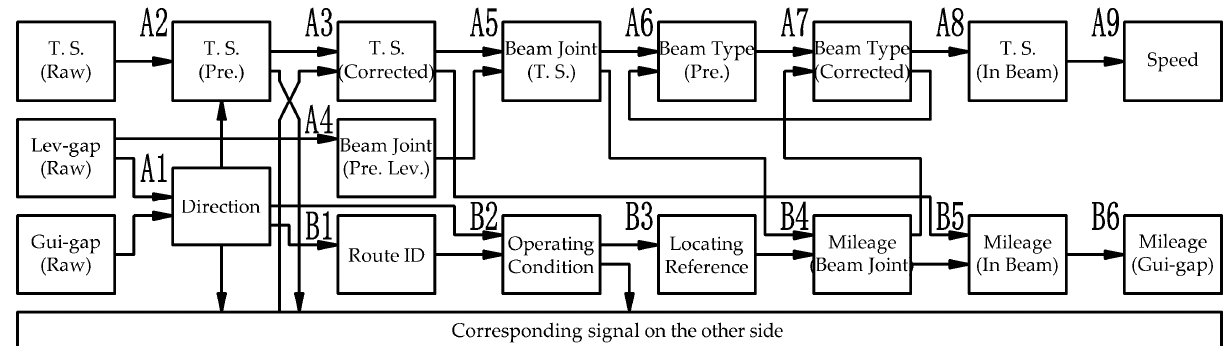
Figure 7. Locating algorithm of guideway inspection data (single side).